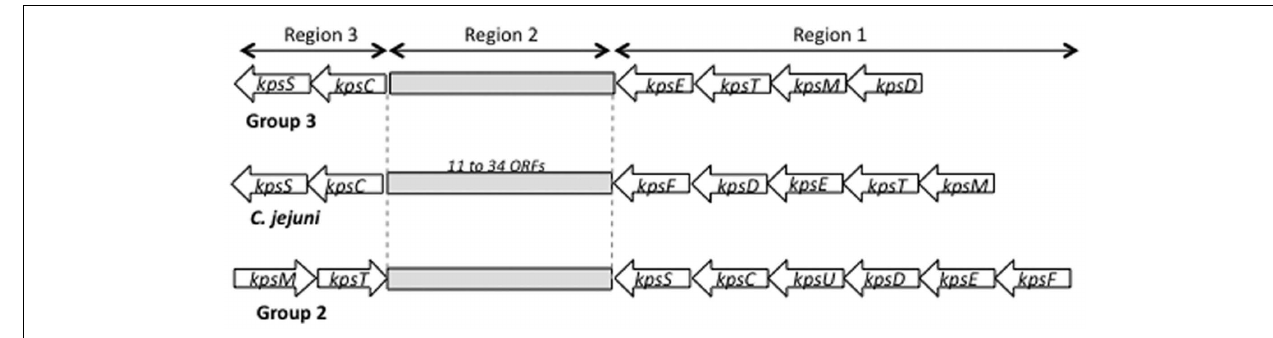
FIGURE 2 | Schematic of the capsule regions of E. coli group 2 and group 3 capsules compared to C. jejuni .